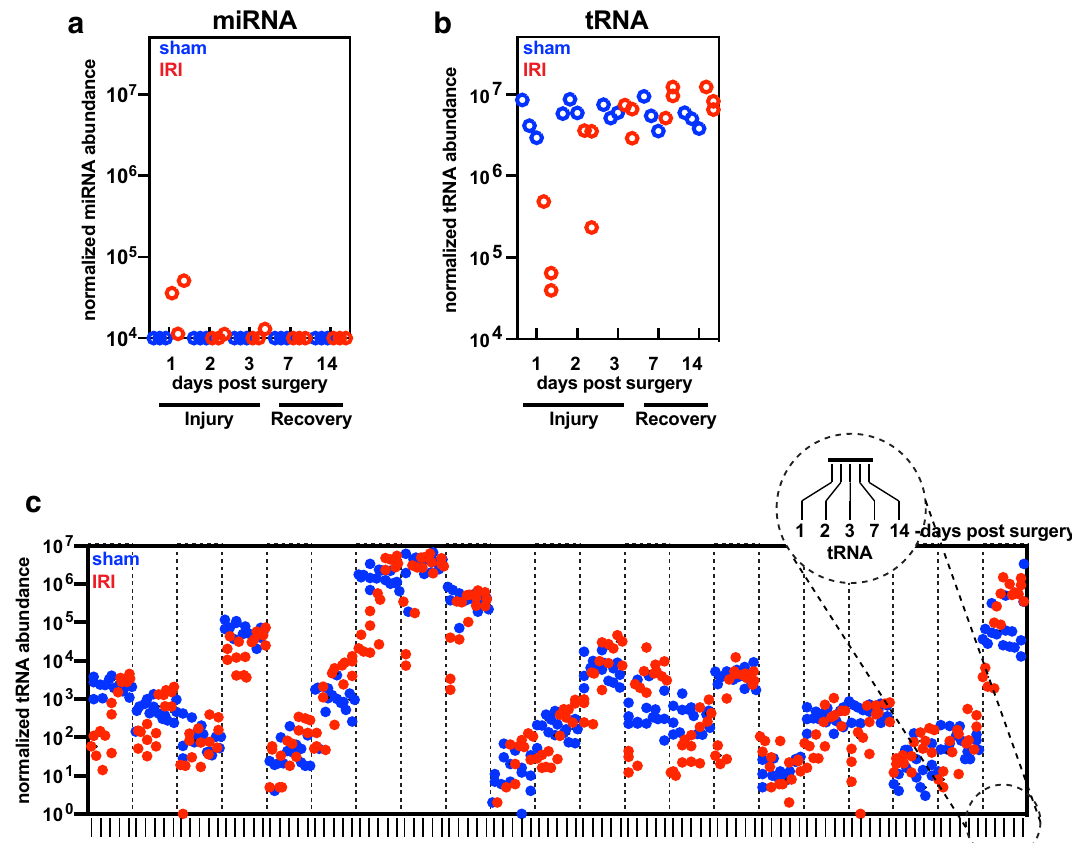
Figure 1. Identification of isoaccepting tRNAs differentially released in extracellular vesicles of urine from kidney injury. ( a and b ) Interleaved scatter plots showing expression levels of the indicated RNA species, miRNA ( a ) and tRNA ( b ) in urinary extracellular vesicles from sham (blue) or injured (red) animals during the time course of renal ischemia/reperfusion injury (IRI). The states of injury and recovery were determined based on the levels of serum creatinine and urea nitrogen. The dataset used for this re-analysis was previously published in GEO database (GPL18694) and our publication 14 . All read counts were normalized using DEseq2 package. ( c ) A scatter plot showing normalized expression levels of isoacceptor tRNAs in urinary extracellular vesicles from sham (blue) and IRI (red) at the indicated days following renal ischemia/reperfusion injury. Alphabet letters denote the 21 genetically-encoded amino acids. All read counts were normalized using DEseq2